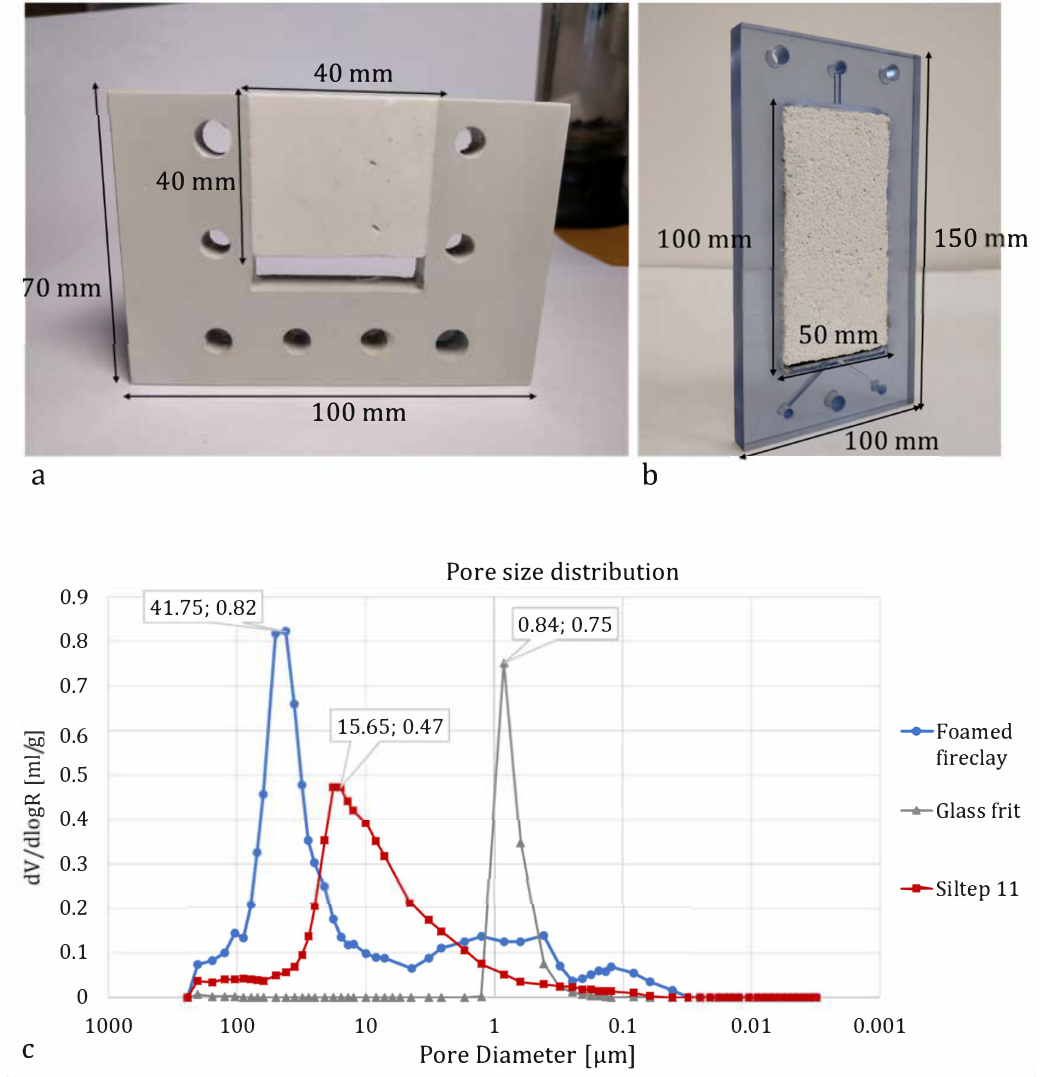
Figure 4. Comparison of ( a ) frame with a porous medium installed for “Gen. III” unit and “Gen. IV” unit. In ( a ), the separator is not included but sits on top of the exposed side of the porous medium instead. In ( b ), the separator is integrated down at the bottom of the frame. The thickness of the parts is 10 mm both in ( a , b ). ( c ) shows frequency curves for the materials used and glass frit used before as a